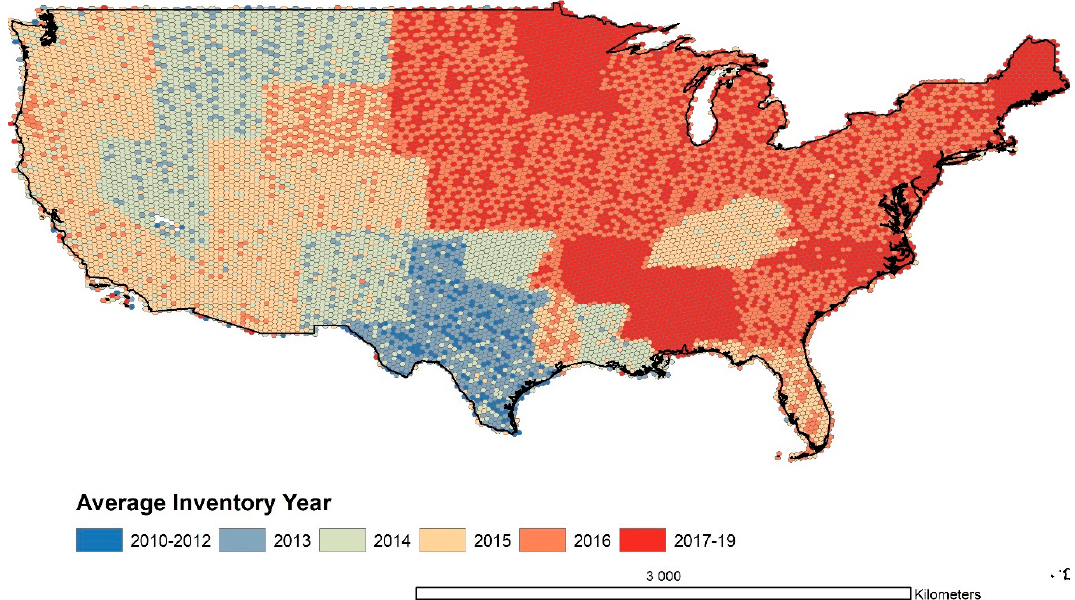
Figure 6. The average year of data collection for the inventory data used in the FIA estimates presented in this paper.